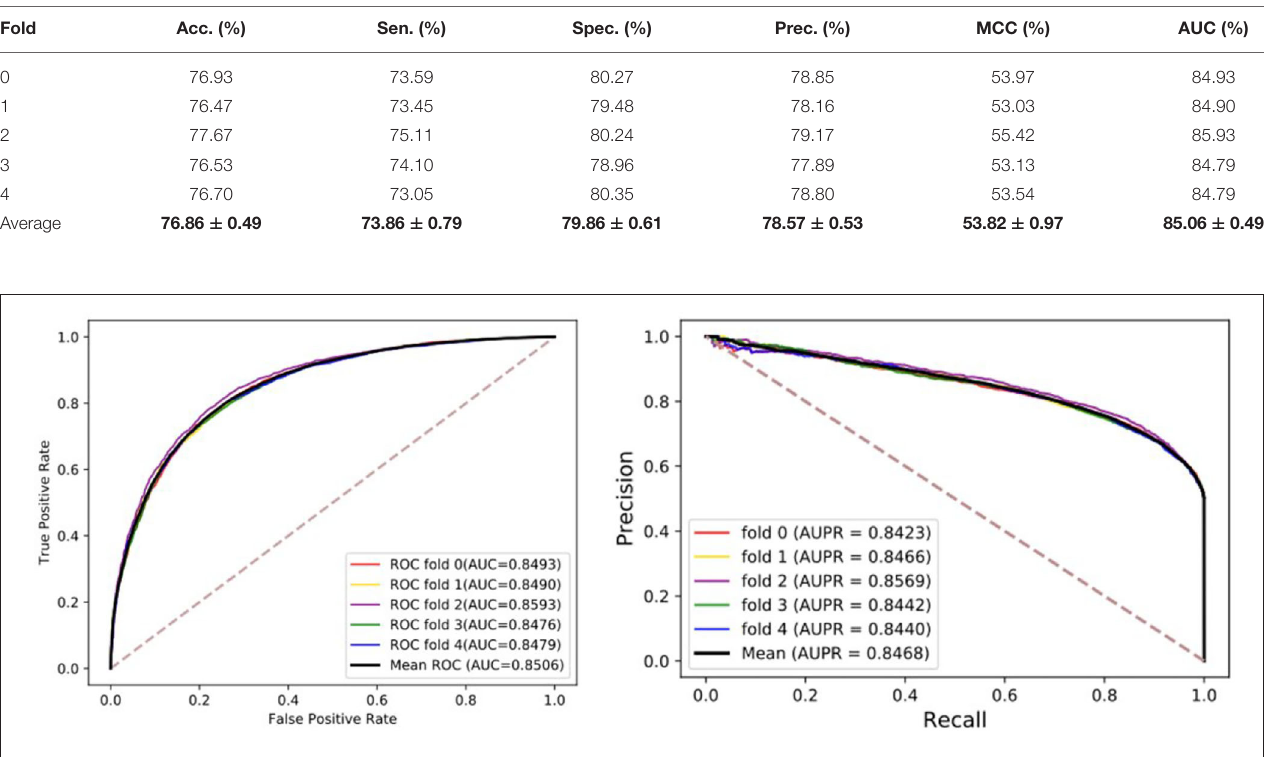
FIGURE 2 | The ROCs, AUCs, PRs, and AUPRs of MGRL under five-fold cross-validation on the benchmark dataset.